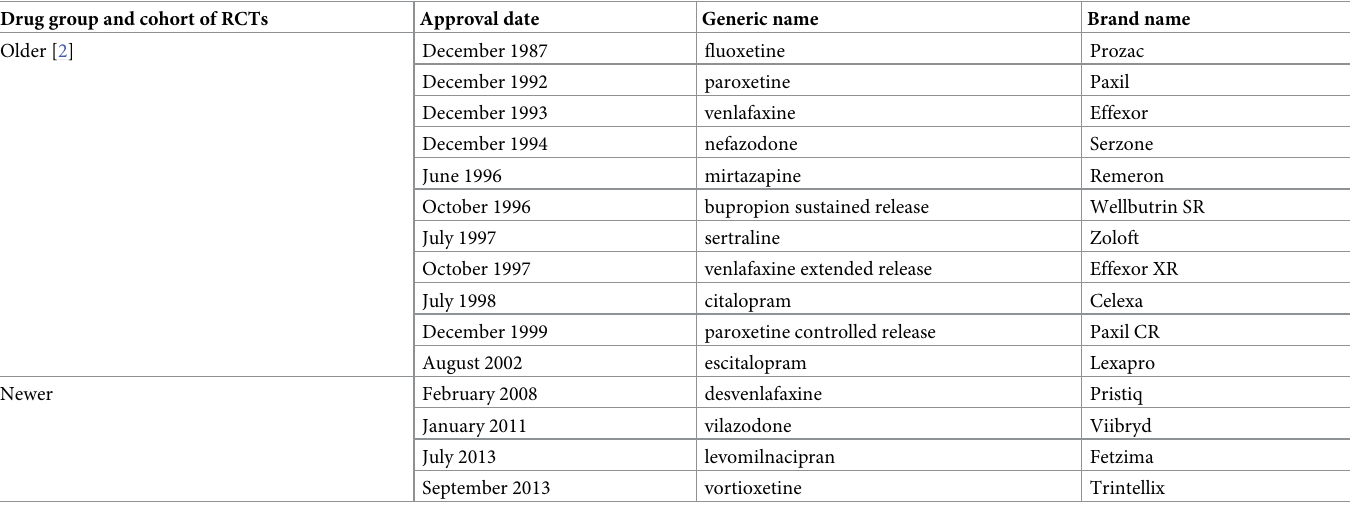
Table 1. List of antidepressants included in the older and newer cohorts of RCTs. Drug group and cohort of